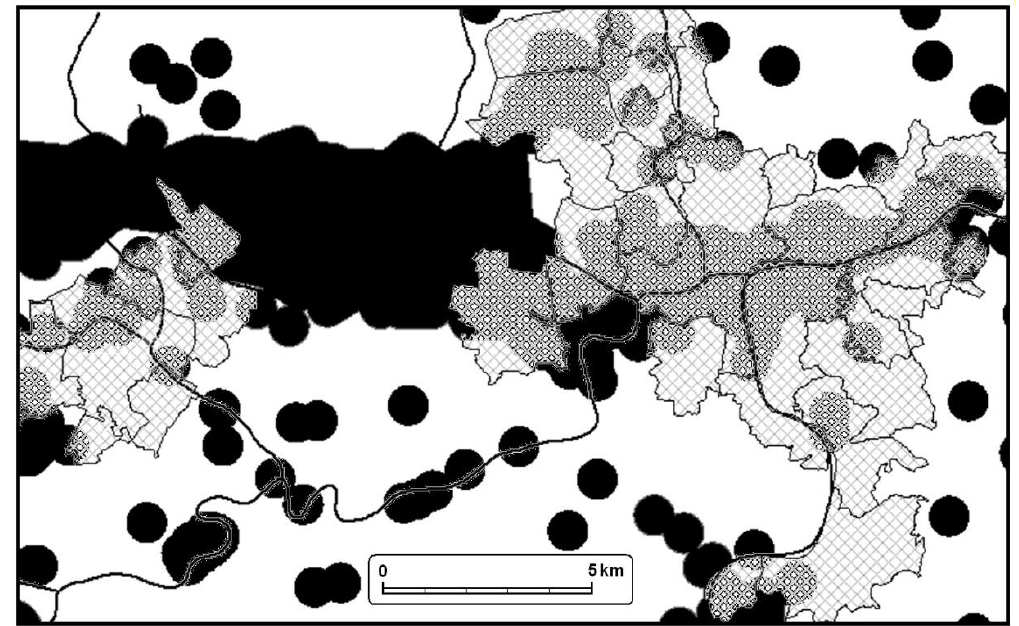
Fig. 3. Example of "wrapping" of point locations and areas of indicators PIL buffers of the width of 500 m (black) by overlapping and then removing areas of indicators of post-industrial landscape in areas of large cities (grey) (Data sources: CENIA, Czech Geological Survey, CORINE LC 2006 CzechInvest, ČÚZaK,